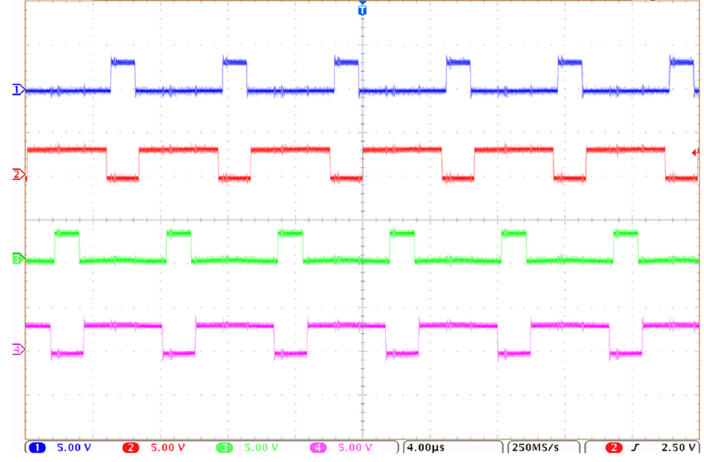
Figure 7. Waveforms of the control signals of MOSFET Q1 (blue), MOSFET Q2 (red), MOSFET Q3 (green) and MOSFET Q4 (bottom) when the load resistance is 40 Ω and without the spread spectrum. Scale: 4 μ s/div.; 5 V/div.